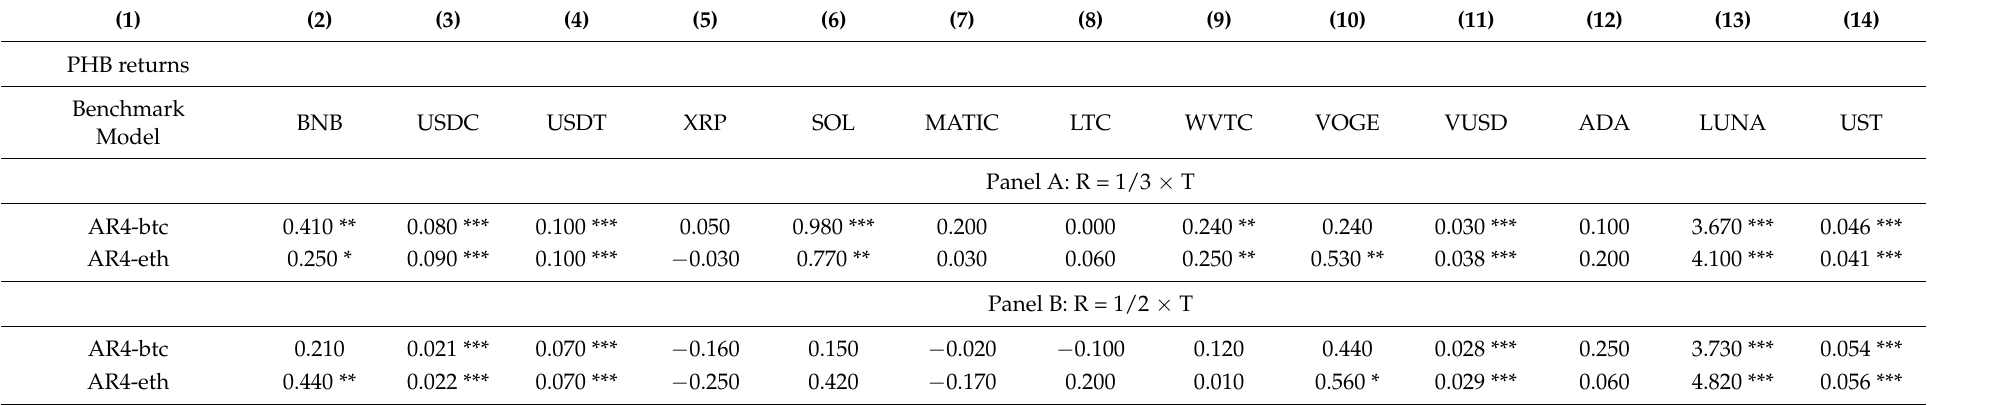
Table 7. The out-of-sample results using a trading strategy for different benchmarks and estimates